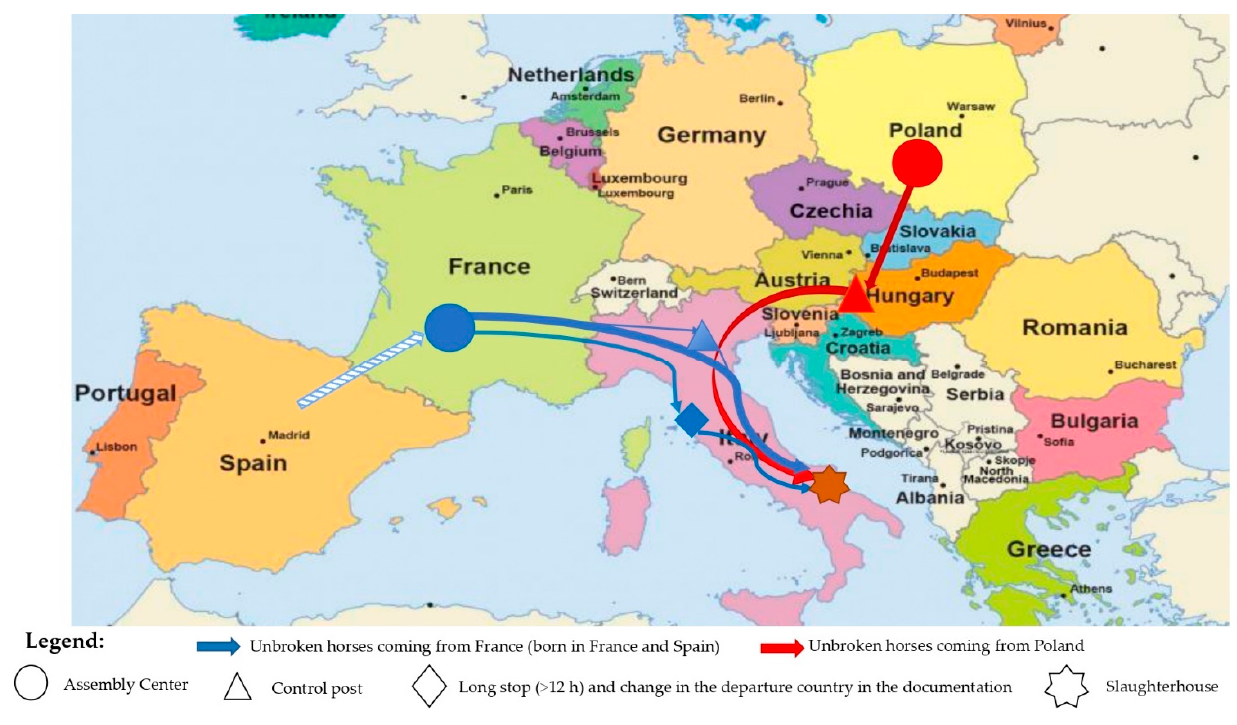
Figure 1. Journey routes of 395 unbroken horses travelling towards a slaughterhouse in Southern